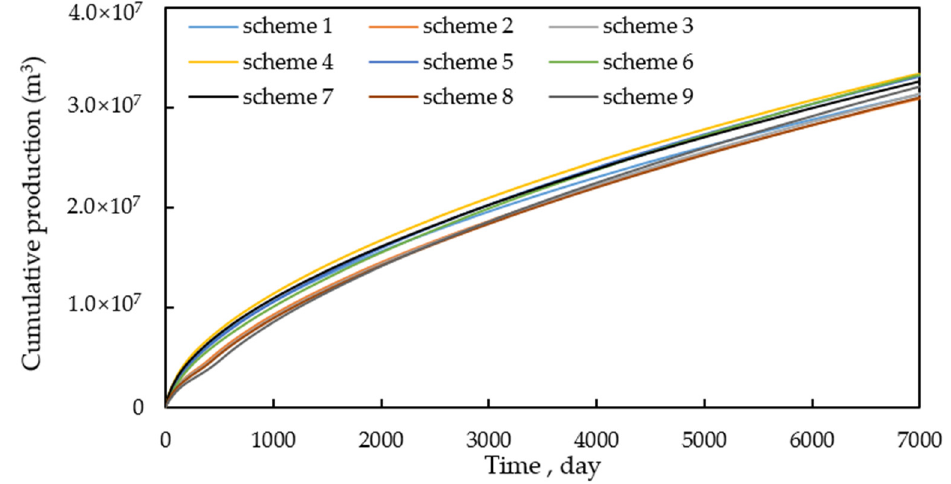
Figure 14. Cumulative gas production curve of single well after different development schemes of deviated well. Table 7 is the yield analysis table of the different schemes of deviated wells.